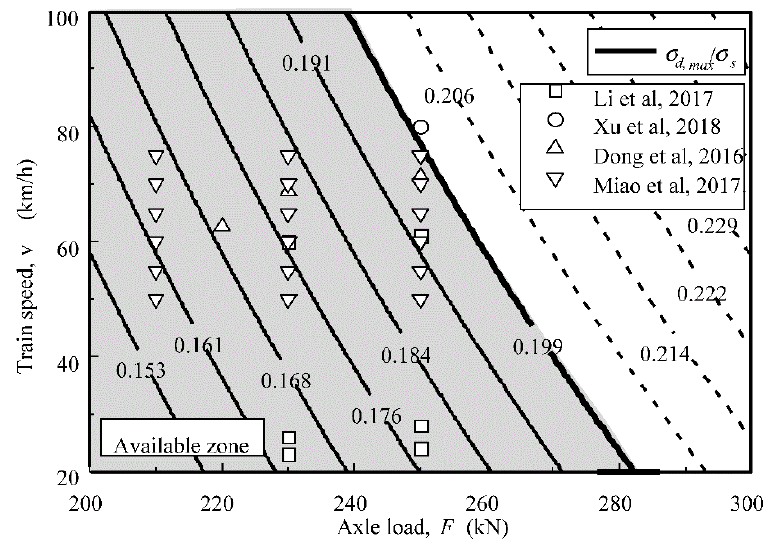
Figure 13. Effects of train speed ( v ) and axle load ( F ) on long-term stability of the existing heavy-haul railway system [7,25,35,36].